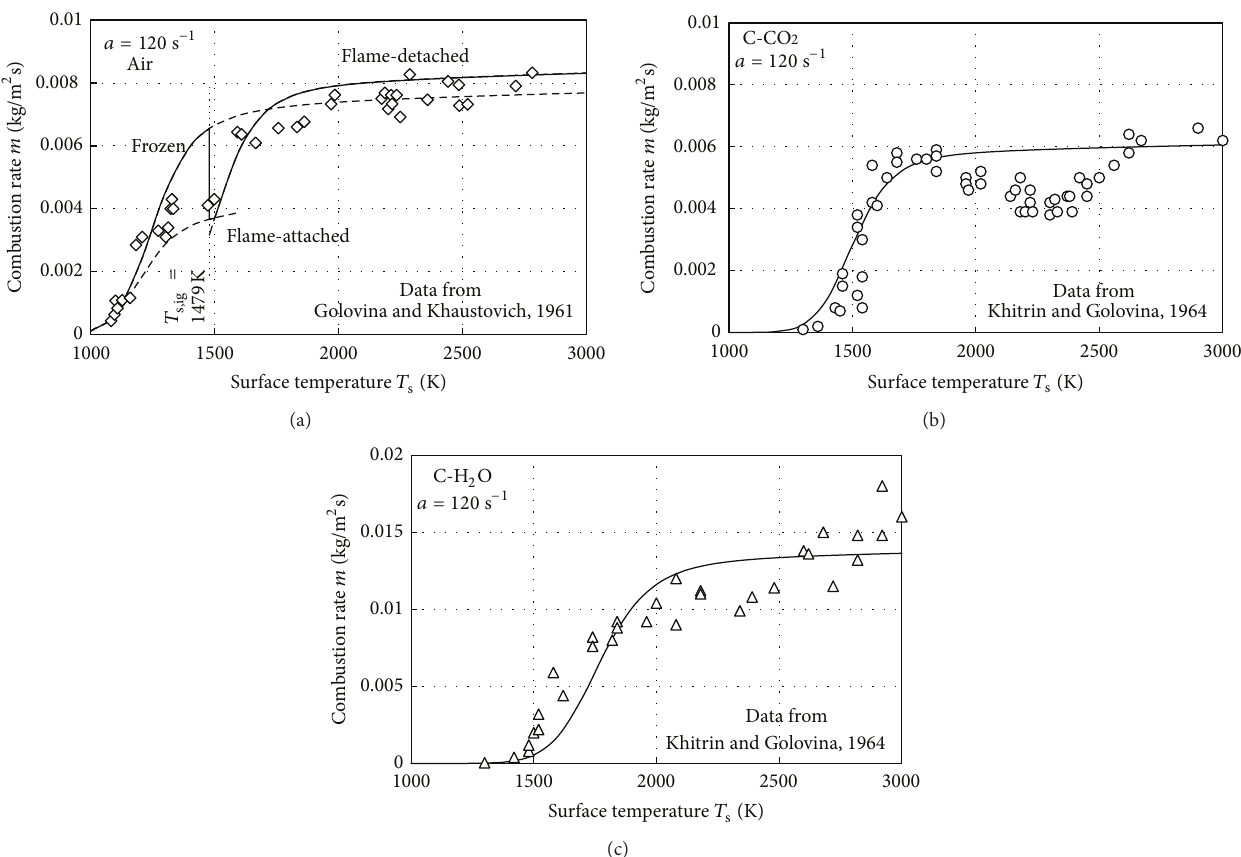
Figure 5: Experimental comparisons for the combustion rate under an atmospheric pressure: (a) in airflow; (b) in CO 2 -flow with CO 2 mass fraction of 0.5; (c) in H 2 O-flow with H 2 O mass fraction of 0.5. Data points are experimental [33, 55] and curves are calculated from the